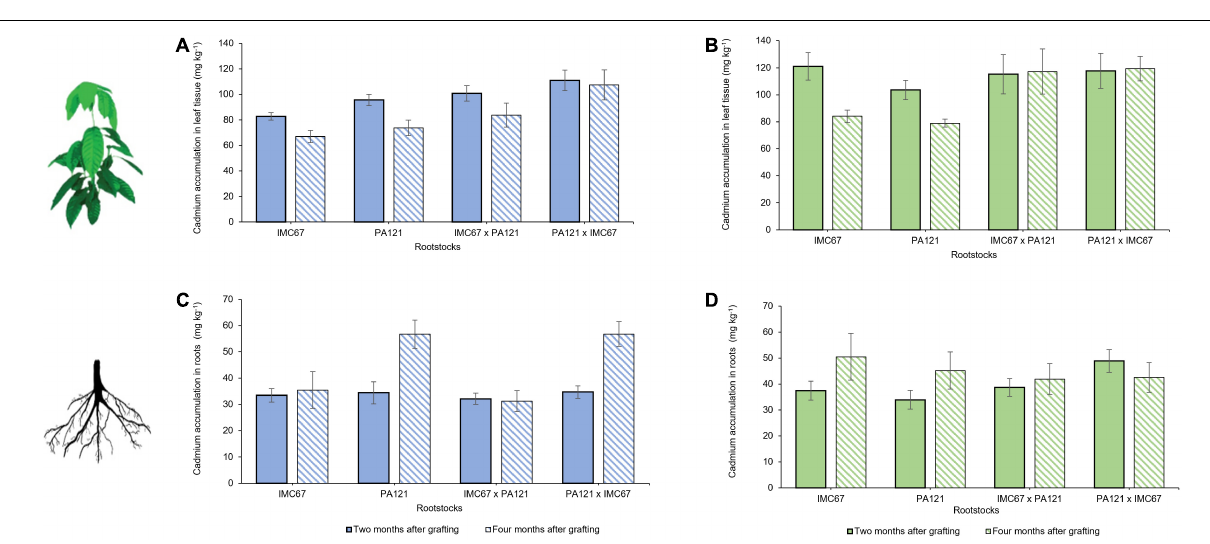
progenies IMC67 and PA121, and full-sib IMC67 × PA121